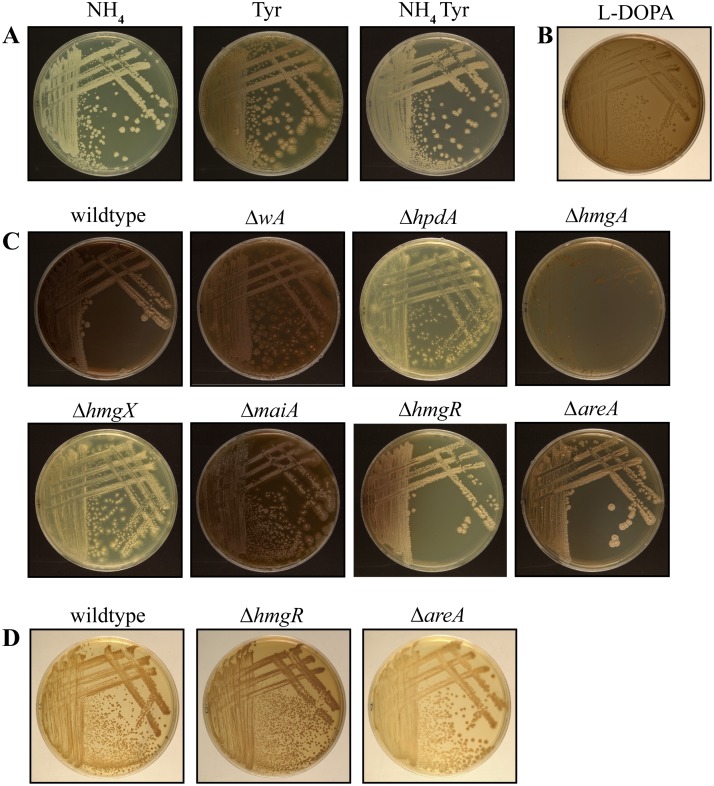
Pyomelanin produced via the tyrosine catabolism pathway is under nitrogen metabolite repression.A. Wildtype grown for 14 days at 37°C on ANM plus ammonium (NH4) or tyrosine (Tyr) as the sole nitrogen source or plus both ammonium and tyrosine (NH4 Tyr). Pyomelanin production via tyrosine catabolism is under nitrogen metabolite repression. B. Wildtype P. marneffei grown on L-DOPA medium for 14 days at 37°C. C. Pyomelanin formation on ANM plus alanine and tyrosine for 14 days at 37°C in the wildtype, ΔwA, ΔhpdA, ΔhmgA, ΔhmgX, ΔmaiA, ΔhmgR and ΔareA strains after 14 days growth at 37°C. D. Wildtype, ΔhmgR and ΔareA grown for 14 days at 37°C on ANM plus ammonium and tyrosine. The ΔhmgR mutant produces increased pyomelanin and the ΔareA mutant produces decreased pyomelanin under this growth condition.